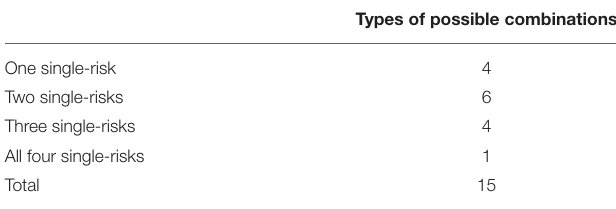
TABLE 3 | List of possible combination of